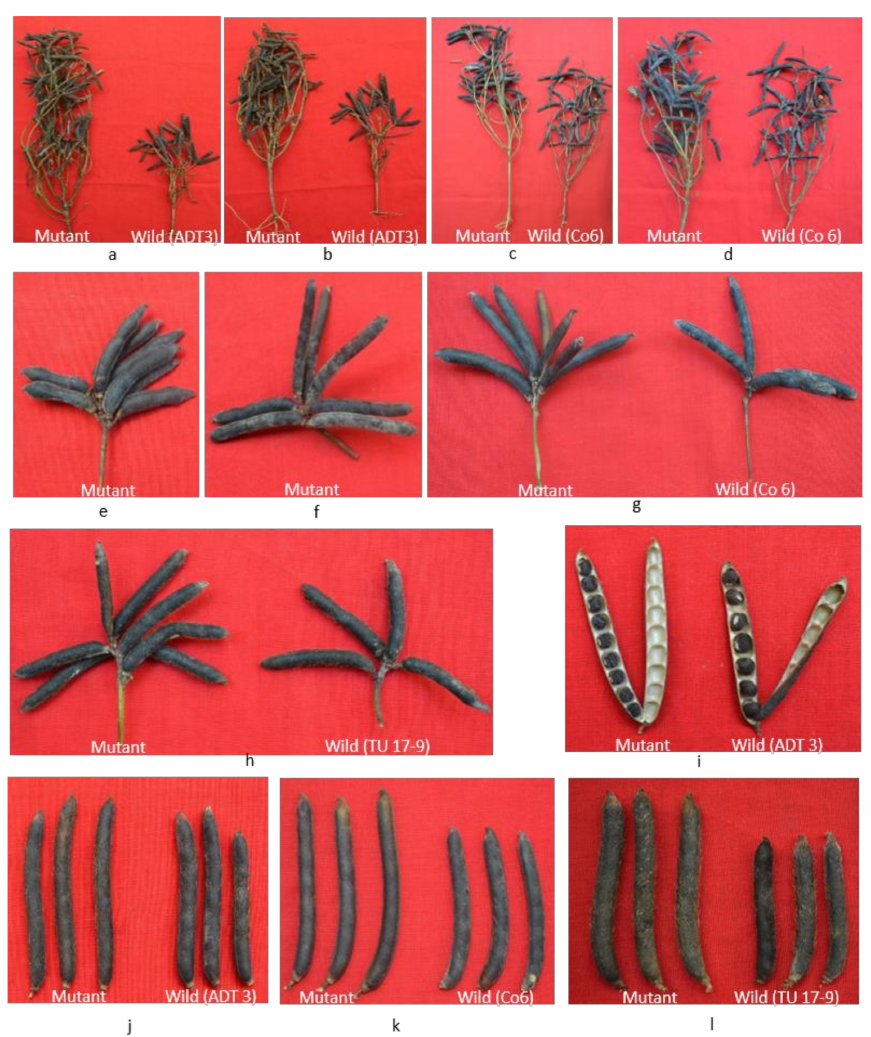
Figure 3. Mutants showing variations in yield-related traits: ( a , b ) mutants derived from cv. ADT 3 exhibiting increased pod numbers per plant, ( c , d ) mutants derived from cv. Co 6 showing increased pod numbers per plant; ( e – g ) mutants derived from cv. Co 6 exhibiting increased pod numbers per cluster; ( h ) mutant derived from cv. TU 17-9 showing increased pod numbers per cluster; ( i ) mutant derived from cv. ADT 3 exhibiting increased seed numbers per pod; ( j – l ) mutant derived from cv. ADT 3, Co 6, and TU 17-9 showing increased pod